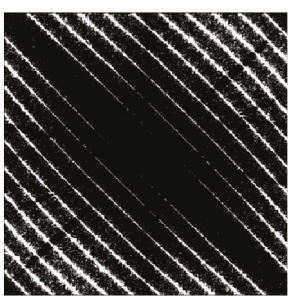
Figure 12: Spectrum of the motion blurred image applying a